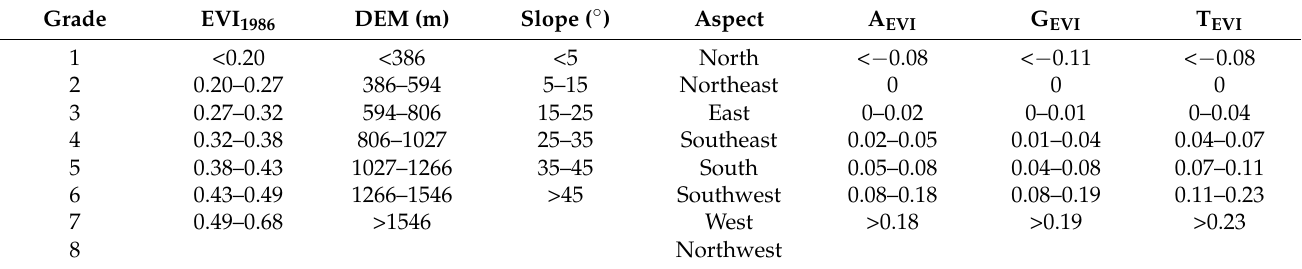
Table 2. Ranges of specific partitions of independent factors.